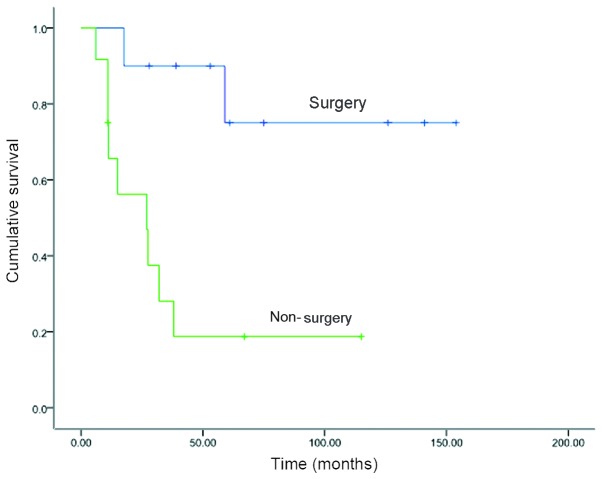
Kaplan-Meier curves comparing the survival time of patients that underwent surgery with those that did not (P=0.004).